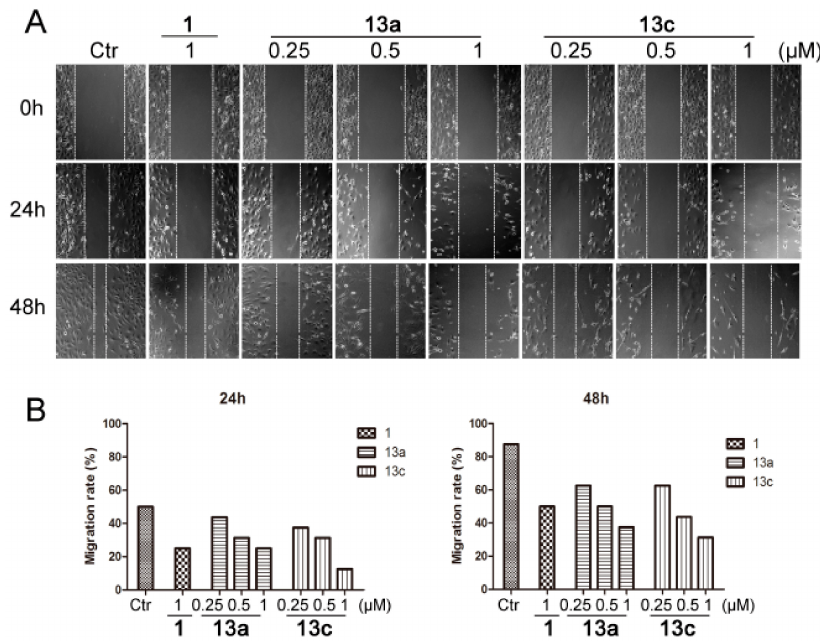
Figure 5. Compounds 13a and 13c inhibited the wound healing of MDA-MB-231 cells. ( A ) After a wound was made by a pipette tip (in six-well plates), cells were treated with di ff erent concentrations of 13a , 13c and SAHA, respectively, and were then photographed at 24 and 48 h. ( B ) Quantitative